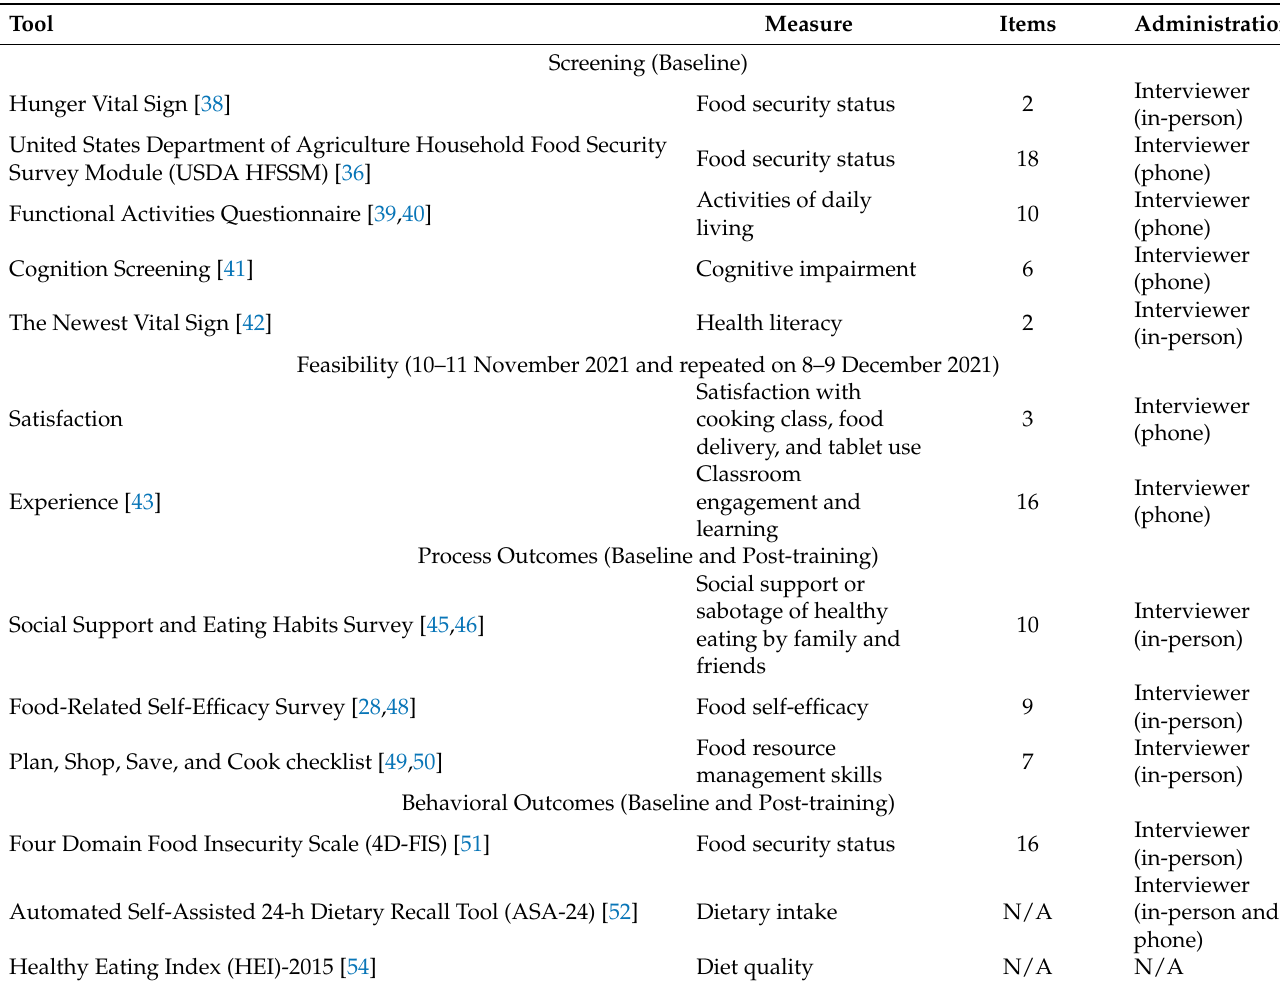
Table 1. Summary of the measurement tools.